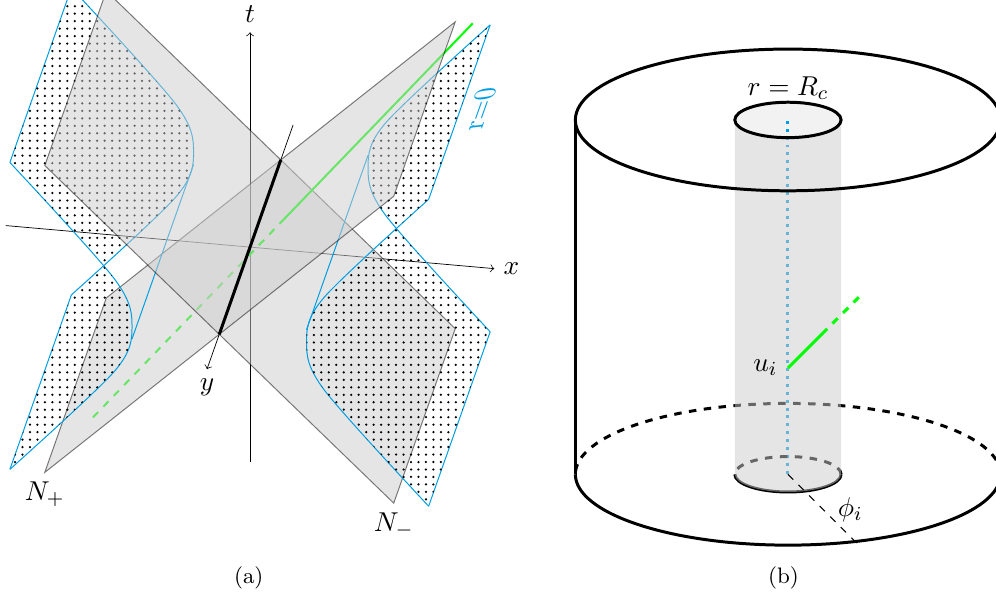
Figure 2 . a) Minkowski Space coordinates. The gray planes correspond to the Cauchy horizon. The planes have been spelled out in equation (5.8). They intersect at the special geodesic (cid:13) H placed at t = x = 0. The dotted surface corresponds to the origin in ADM coordinates. The green line represents a null geodesic. The dashed part is time-like separated from the Cauchy Horizon. b) ADM coordinates. The gray cylinder is the Cauchy Horizon at r = R c . The dotted blue line is the origin r = 0. The green line is a null geodesic that intersects the null boundary at u i ; (cid:30) i